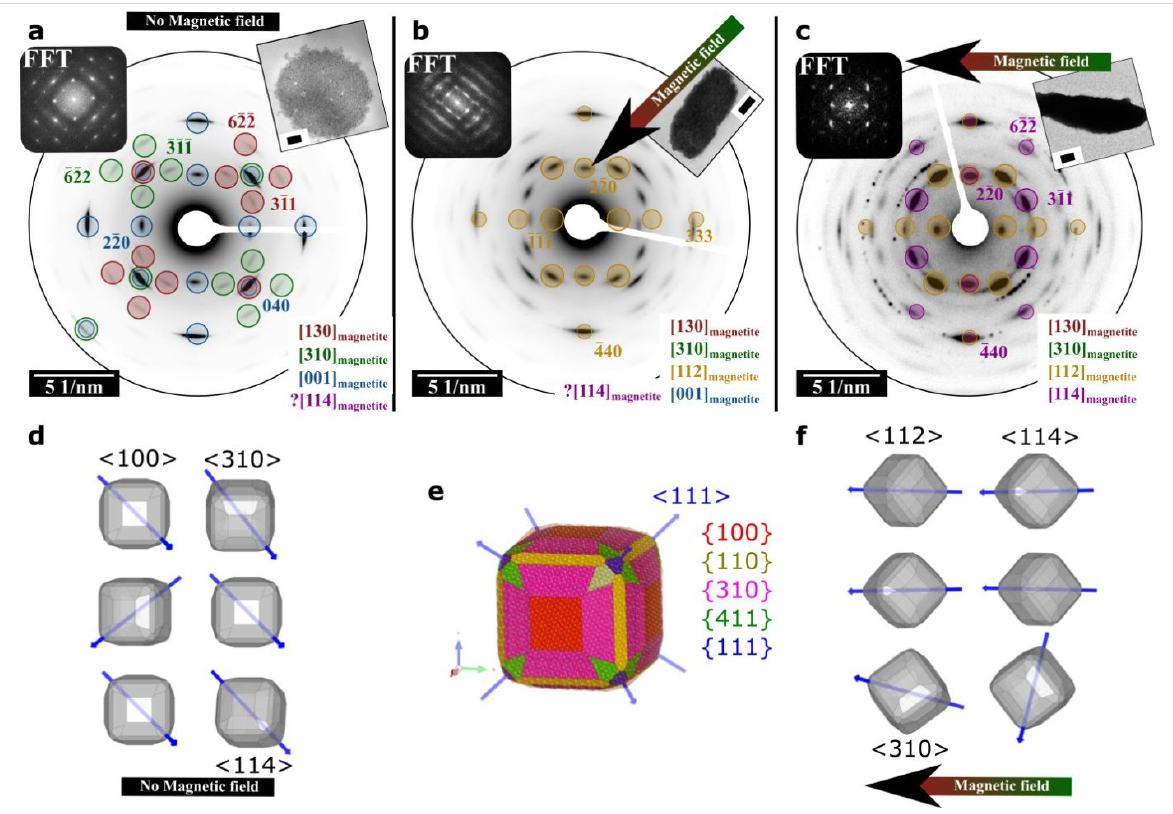
Figure 4: Comparison of a “self-assembled mesocrystal” and two “directed mesocrystals” with a projected p 4 mm layer symmetry of superlattices. (a) Indexed SAED pattern of a “self-assembled” mesocrystal (inset: scale bar = 300 nm) formed without the influence of an applied external field. (b,c) Indexed SAED patterns of a “directed mesocrystal” formed within the applied external magnetic field (120 mT). Here, two additional zone axes ([112] magnetite and [114] magnetite perpendicular to the substrate) contribute to the mesocrystalline structure while in (c) the reflections of the [001] magnetite zone axis almost vanish. The diffraction reflections, which are corresponding to the [112] magnetite and [114] magnetite zone axes of magne- tite, are indicated in yellow and magenta colour, respectively (inset in (b) and (c): scale bar = 300 nm and 200 nm, respectively). Parts (d) and (f) show illustrations of orientational order of nanoparticles within a projected layer (with p 4 mm symmetry) of superlattices prepared without and with magnetic field, respectively. For simplicity only one of all equivalent <111> magnetite directions (corresponding to magnetite easy axis) is indicated (blue arrow). (e) Simulated idealized shape of magnetite nanocube slightly truncated by the {111}, {110}, {310}, and {411} faces. Blue arrows indicate <111> magnetite directions which are corresponding to magnetite easy